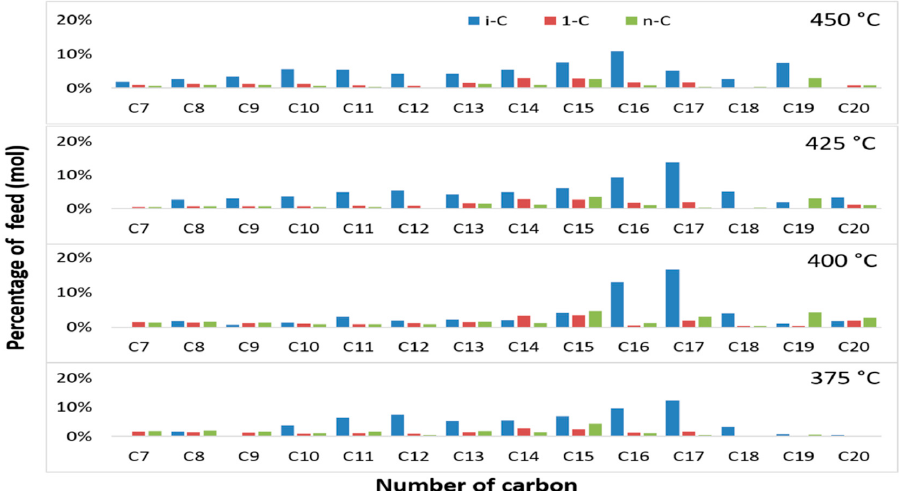
Figure 5. Iso-alkane composition of liquid products from pyrolysis of mixed-metal basic soap at various reaction temperature and with two different Ca/(Ca + Mg + Zn) metal ratios.